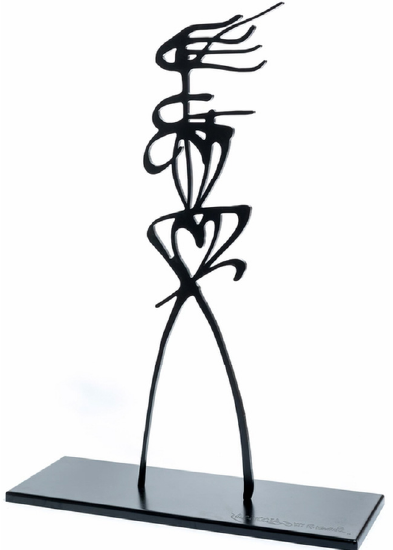
Figure 17. Rachid Koraïchi producing the series “Lachrymatoires Bleues” (Blue Lachrymatory Vases) (ii). 2020. Ceramic with cobalt oxide underglaze, 51 × 31 × 32 cm (RK5050). Screenshot from the film about the shortlisted projects for the Aga Khan Award for Architecture 2022, Aga Khan Development Network (Aga Khan Development Network (AKDN) 2022). © Rachid Koraïchi.